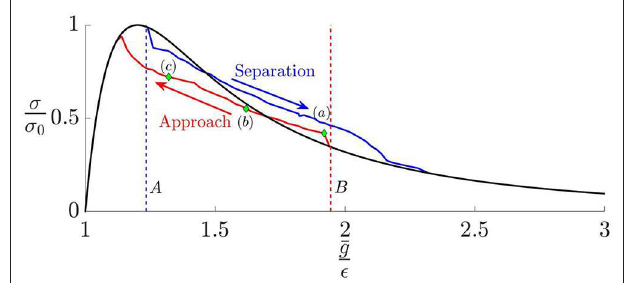
g for a smooth layer σ as a function of mean gap FIGURE 3 | Mean traction ¯ ¯ for β 0.25 and domain size L 8 π h , showing instabilities during approach = = and separation. The Lennard-Jones law (1) is shown in black. The dashed lines A, B define the region in which the uniform traction solution is unstable.